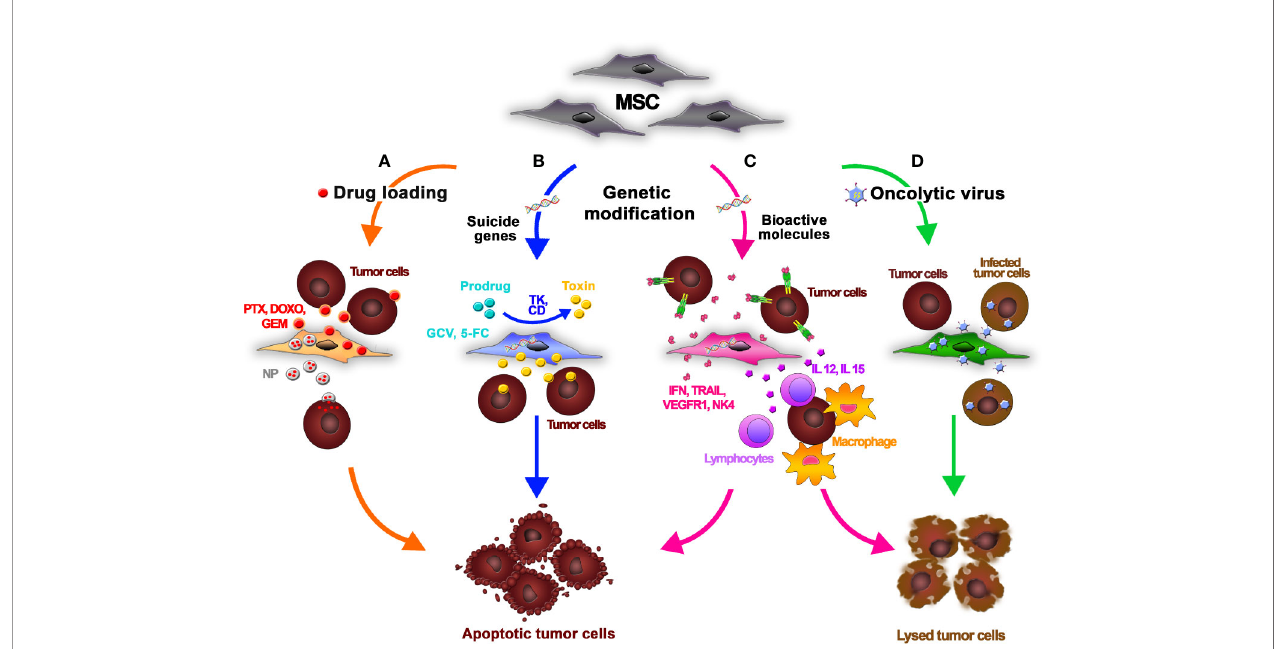
FIGURE 1 | Mesenchymal stromal/stem cells (MSCs) can be functionalized using different strategies to release antitumor agents for cancer treatment. (A) An anticancer drug is dissolved in the MSC culture media. MSCs incorporate the chemotherapeutic into the cytoplasm and then release it into the tumor microenvironment. MSCs ef fi ciently absorb doxorubicin (DOXO), paclitaxel (PTX), and gemcitabine (GEM) and release them in their active forms, inhibiting tumor cell growth. MSCs can also take up drug-loaded nanoparticles (NPs), improving their biodistribution. (B) Using genetic modi fi cation, MSCs can be forced to express suicide genes encoding speci fi c enzymes (e.g., TK, CD) that convert nontoxic prodrugs (GCV, 5-FC) into active derivatives. The prodrugs are systemically administered and then engineered MSCs are intravenously infused. Once injected, MSCs home into the tumor and convert the inactive prodrug into cytotoxic metabolites inside the neoplastic tissue, thus minimizing the off-target toxicity. (C) Genetic modi fi cation of MSCs can be also performed to induce the production of bioactive molecules and immunomodulatory cytokines such as interferons (e.g., IFN- a , IFN- b , IFN- g ), interleukins (e.g., IL-2, IL-12, IL-15,IL-18), chemokines (e.g., CXC3L1), proapoptotic molecules (e.g., TRAIL), antiangiogenic molecules (e.g., Alpha-1 antitrypsin, NK4, VEGFR1), or molecules with other antitumor properties (e.g., TNF-a, HNF4-a). These proteins can both act directly on tumor cells, inducing apoptosis, and potentiate the host in fl ammatory response through crosstalk with tumor-in fi ltrating leukocytes. (D) MSCs act as carriers and ampli fi ers of oncolytic viruses, protecting the viruses from host immune responses and delivering them into tumor